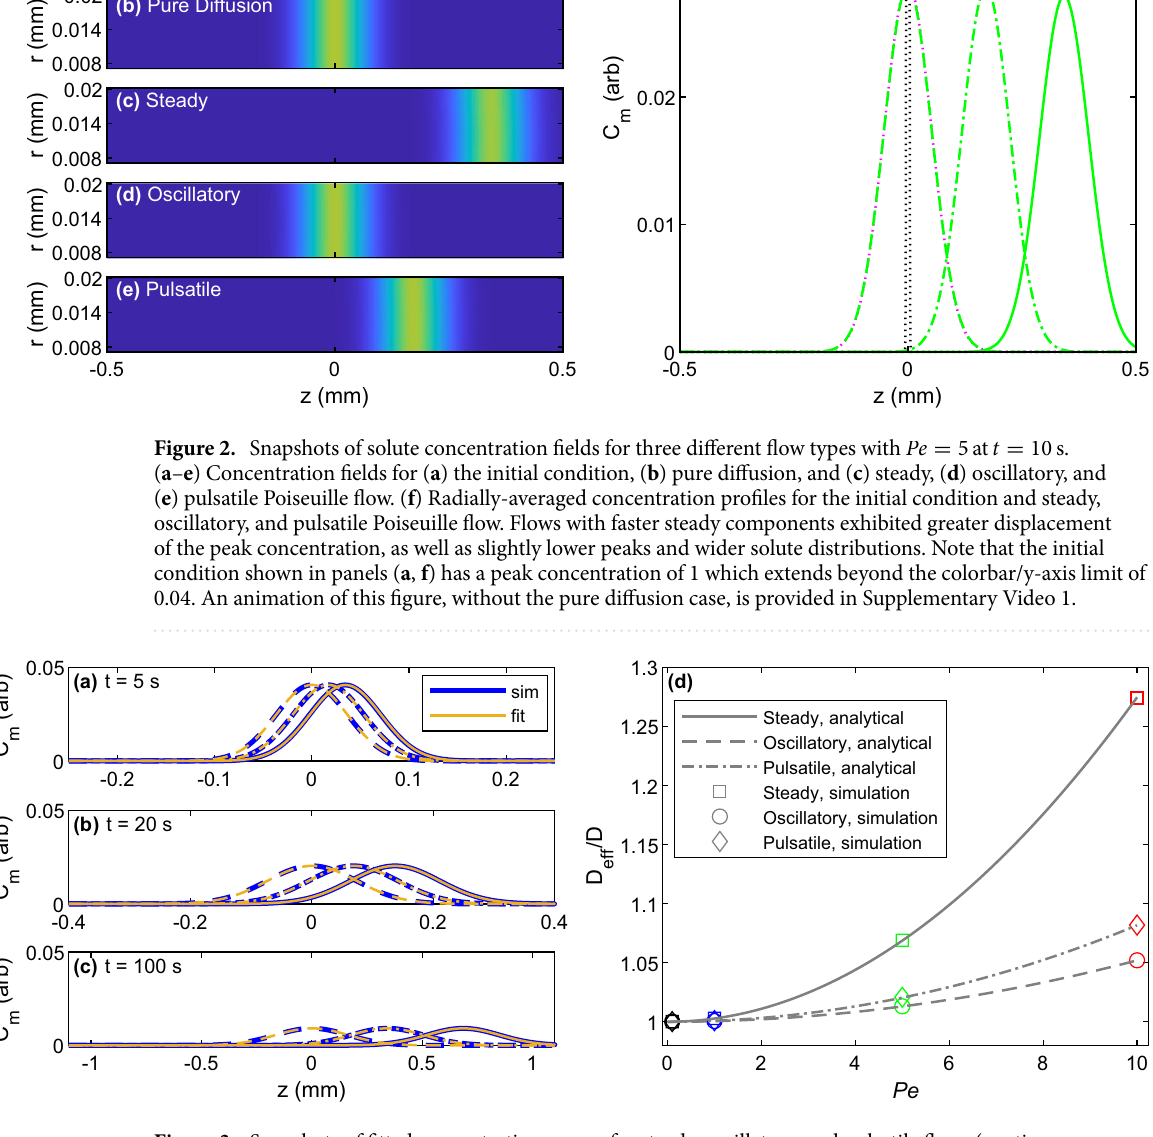
1 at ( a ) t 5 , ( b ) t 20 , and ( c ) t 100 . Note that = = = = 0.1 , blue for Pe 1 , green for Pe 5 , and red = = =